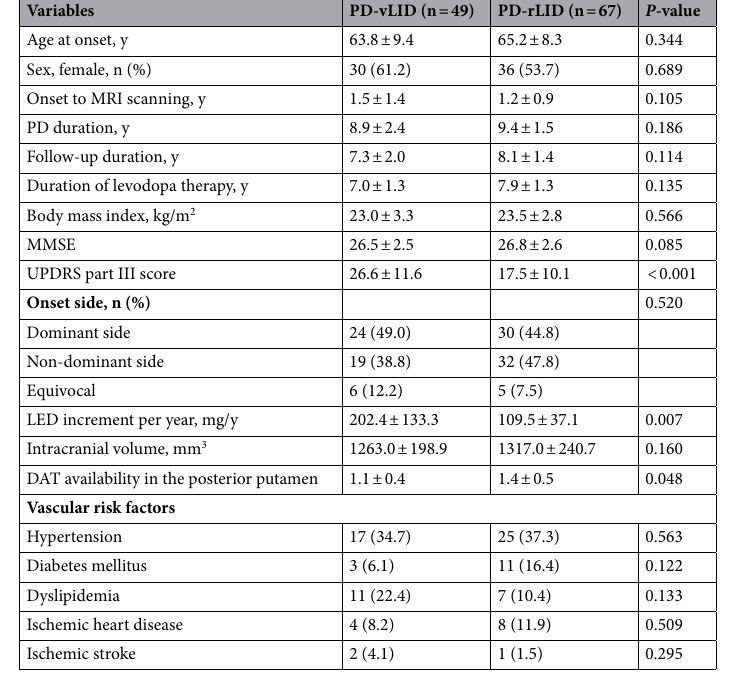
Table 1. Demographics and clinical characteristics of patients with Parkinson’s disease. Values are expressed as the mean ± standard deviation or number (percentage) as appropriate. DAT, dopamine transporter; LED, levodopa-equivalent dose; MMSE, Mini-Mental State Examination; MRI, magnetic resonance imaging; PD, Parkinson’s disease; UPDRS, Unified PD Rating